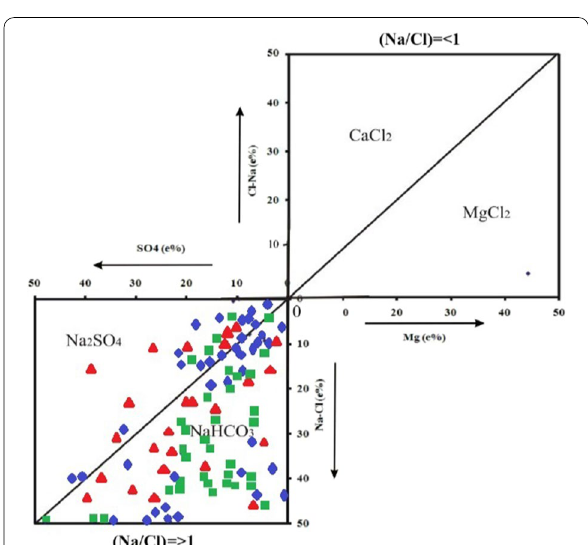
Fig. 10 Sulin’s diagram for some groundwater samples in the (red triangle) old cultivated land area, (blue diamond) outlet area and (green square) intermediate area of wadi